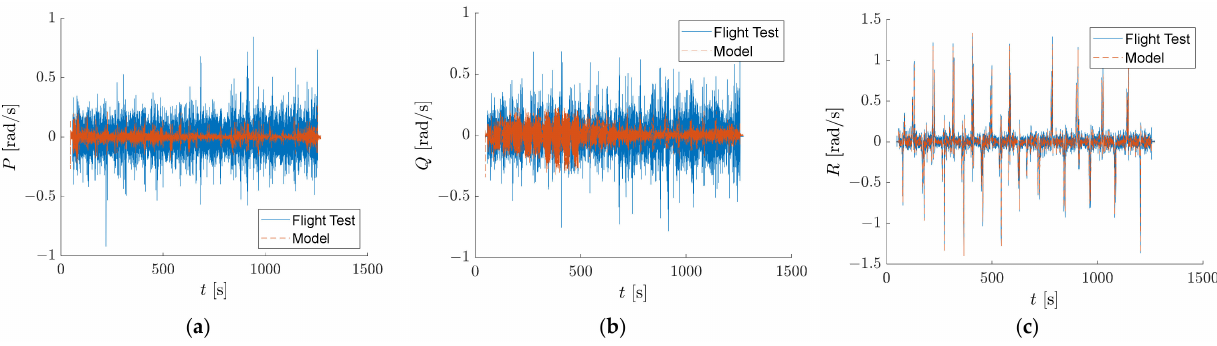
Figure 18. Angular rates: ( a ) roll, ( b ) pitch, and ( c )